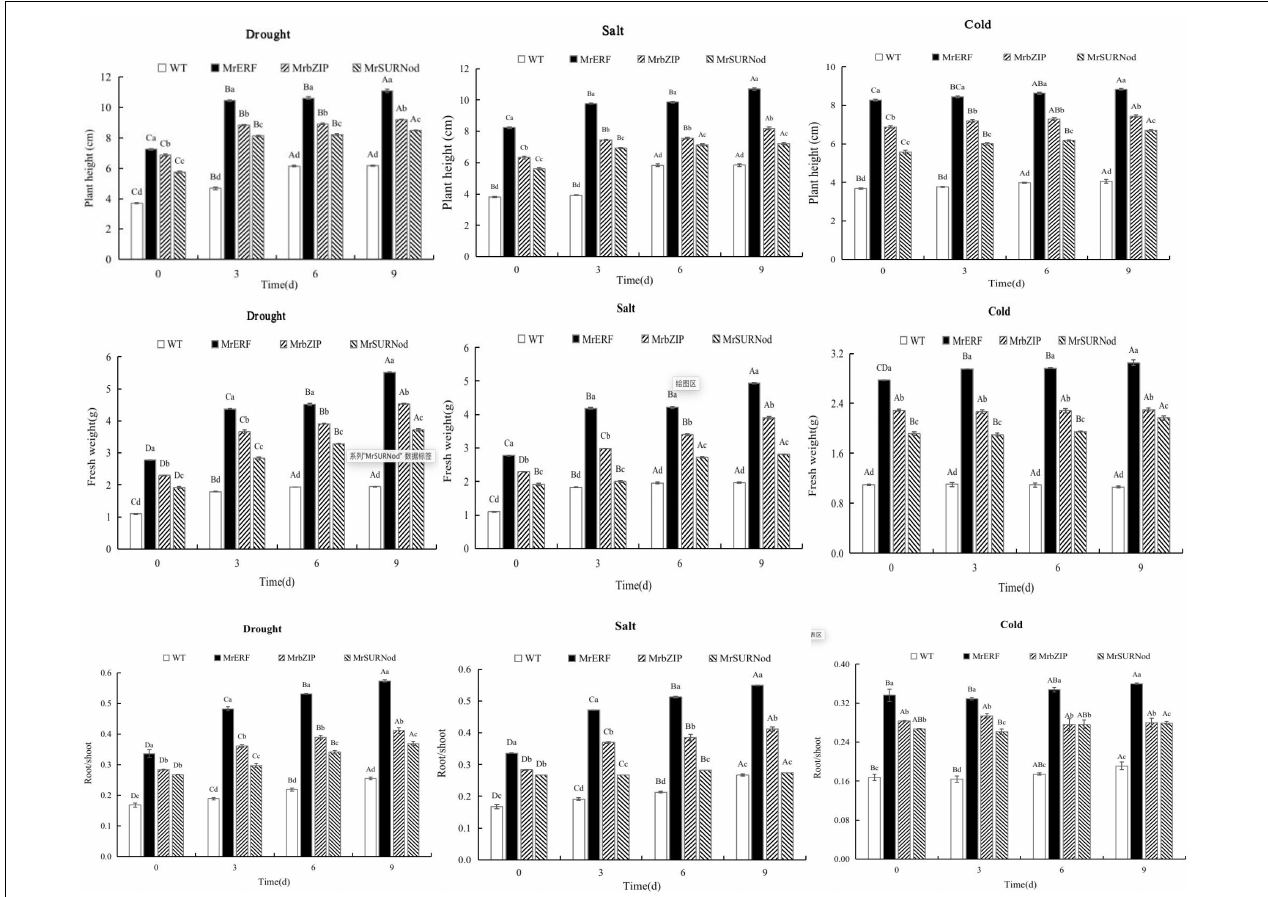
FIGURE 7 | Plant height, biomass, and root/shoot of transgenic tobacco under abiotic stress. Different capital letters indicate significant differences under different treatments, and different lowercase letters indicate significant differences among different transgenic lines in the same treatment ( P <